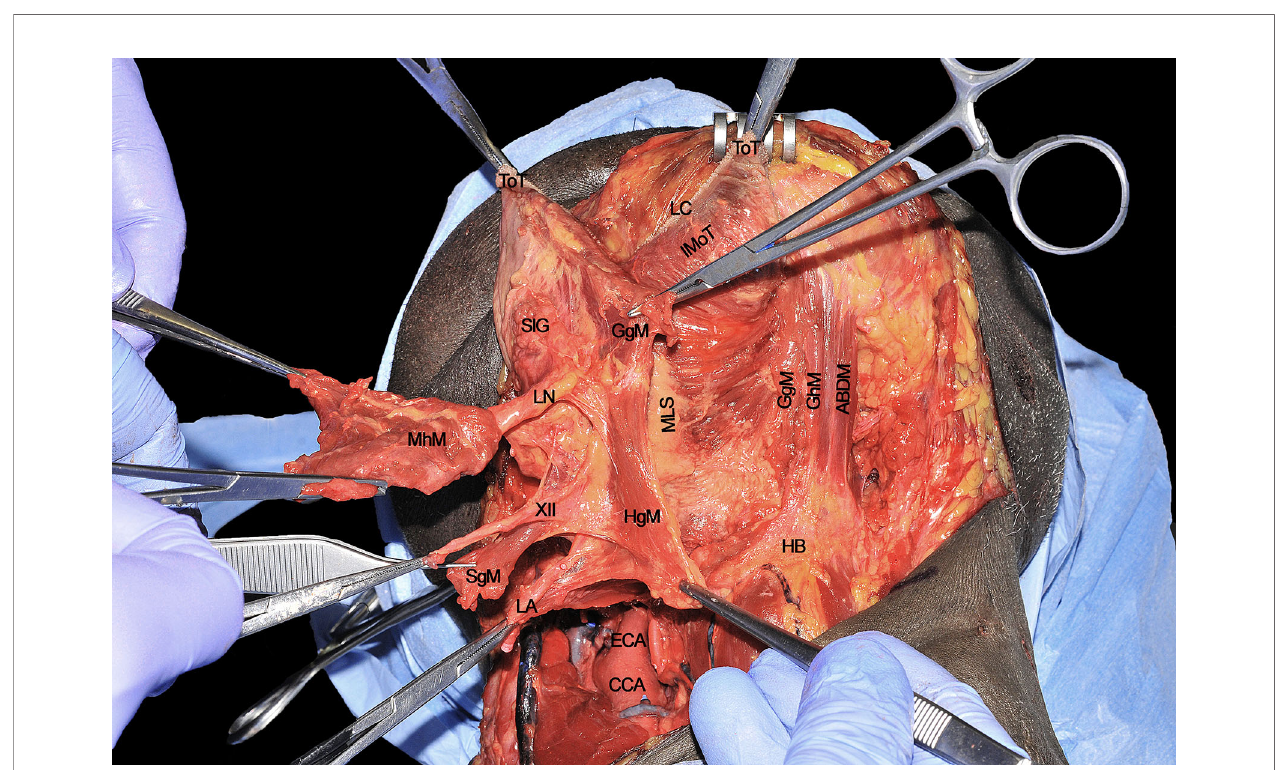
FIGURE 12 | ABDM, anterior belly of digastric muscle; CCA, common carotid artery; ECA; external carotid artery; HB, hyoid bone; HgM, hyglossus muscle; GgM, genioglossus muscle; GhM, geniohyoid muscle; IMoT, intrinsic muscle of tongue; LA, lingual artery; LC, lingual cover; LN, lingual nerve; MhM, mylohyoid muscle; MLS, median lingual septum; SgM, styloglossus muscle; SlG, sublingual gland; ToT, tip of tongue; XII, hypoglossal